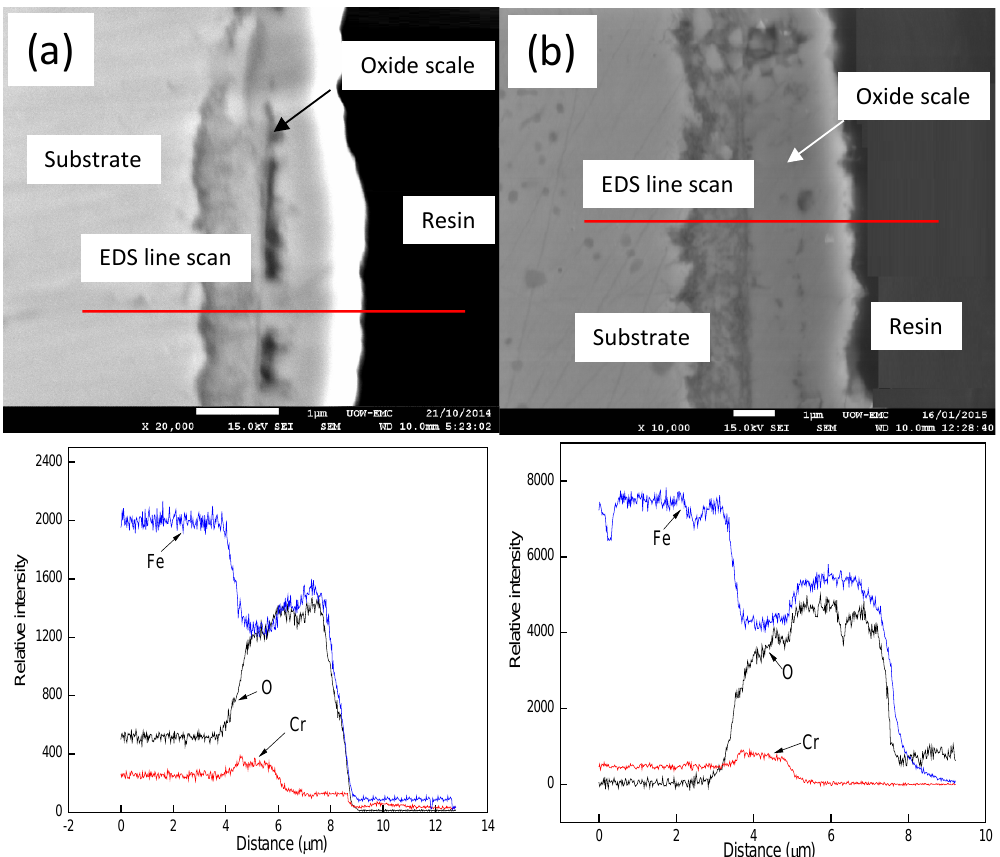
Figure 9. Cross sections and corresponding energy dispersive spectrometer (EDS) line scanning analysis of the HSS oxidized at 650 °C in ( a ) dry air and ( b ) humid air.